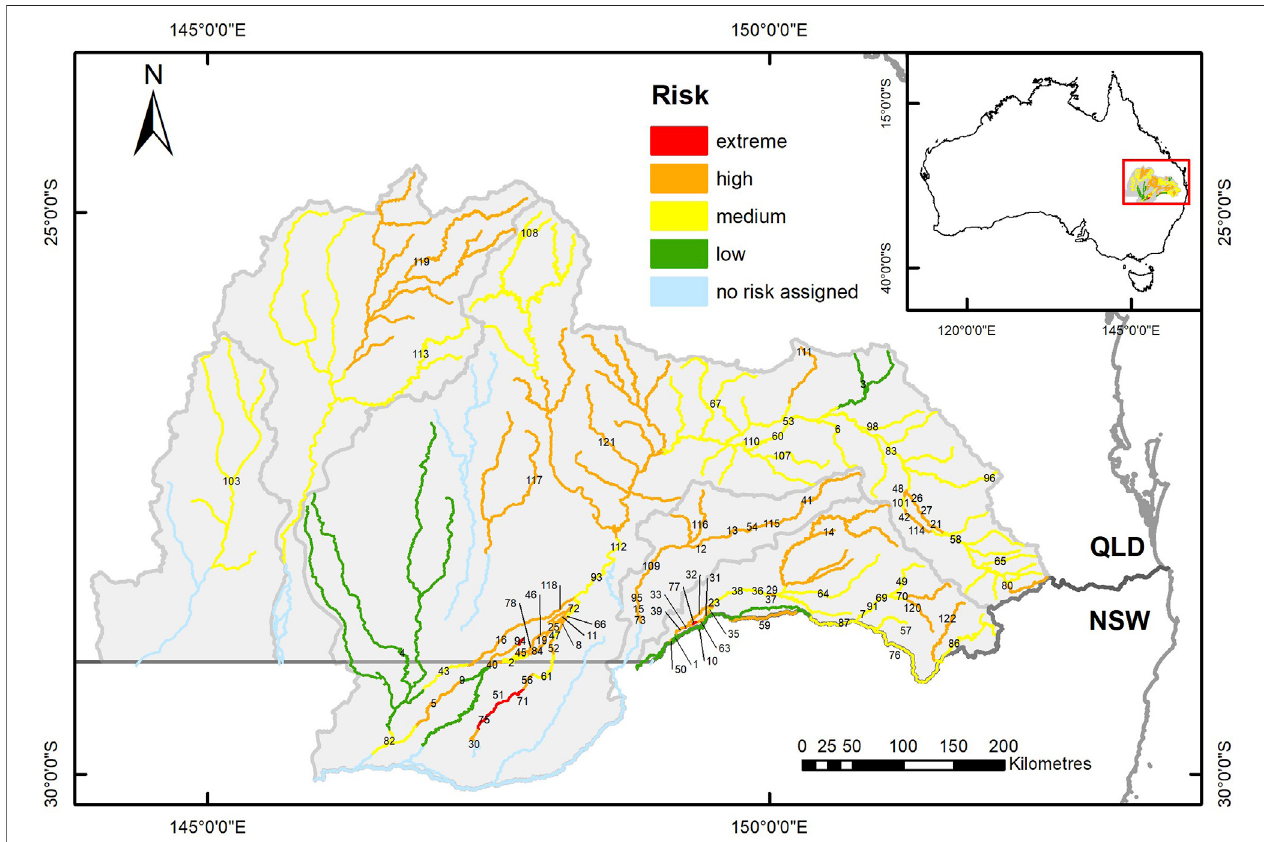
FIGURE 7 | Map of the study area showing river segments, de fi ned by barrier locations, colour coded to indicate the spatial distribution of the combined risks to local fi sh populations from drought limitation of refuge waterhole habitat availability and long-term barrier impacts on movement opportunities. Labels indicate the segment ID numbers listed in Supplementary Table S3